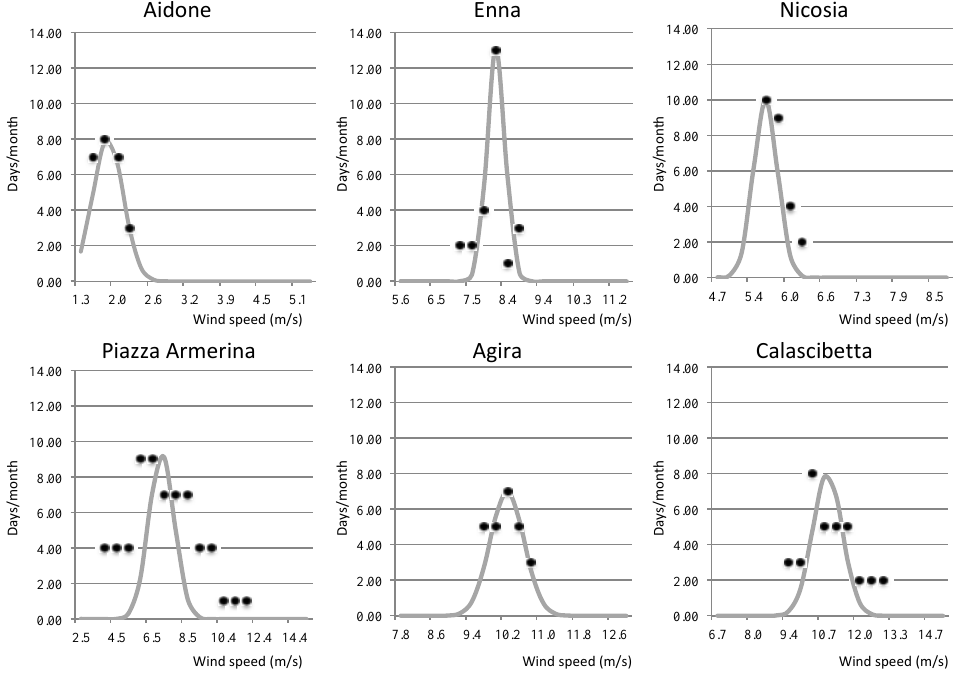
Figure 3. Calculated windiness 80 m above the ground—Province of Enna.